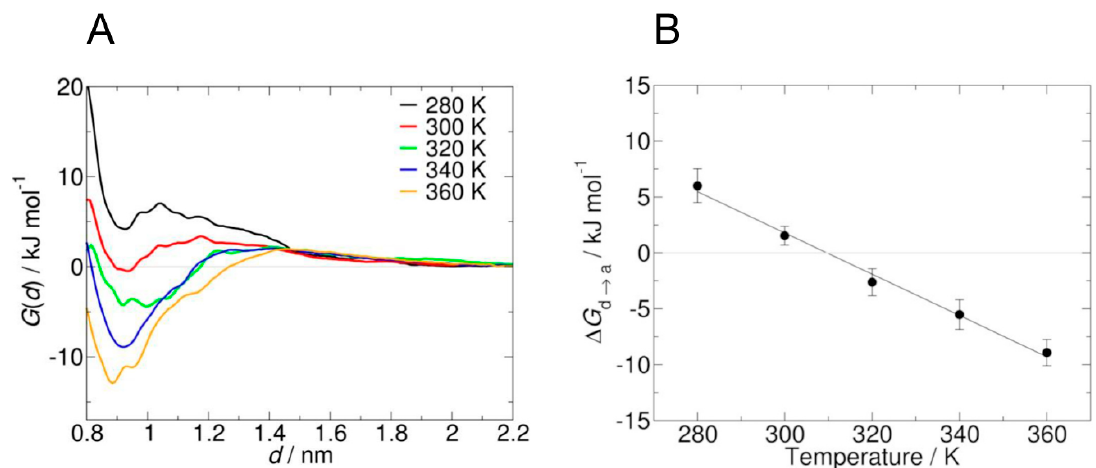
Figure 3. Potential of mean force of the transition between dissolved and aggregated state of poly( N -isopropylacrylamide (PNIPAM) in water at different temperatures, scaling mixing rules by a factor equal to 1.1 ( A ). Free energy change between dissolved and aggregate state at different temperatures ( B ). Reprinted from Garcìa et al. [48] , Copyright 2018 Elsevier.